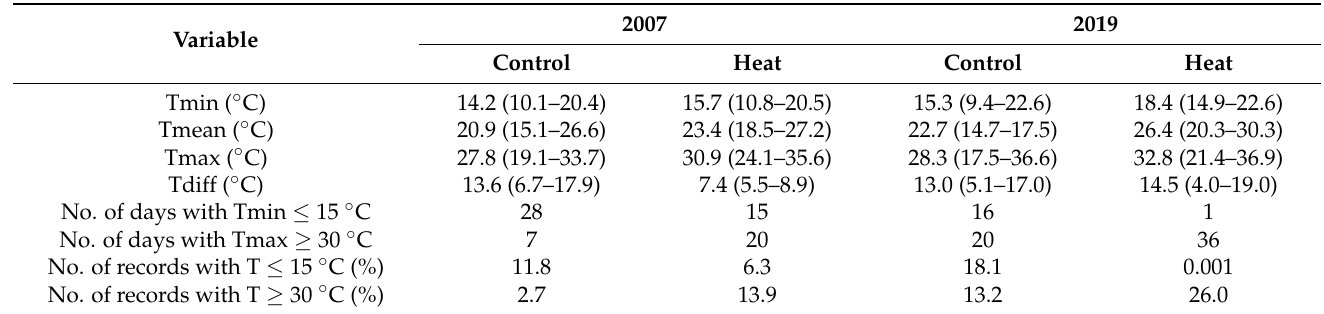
Table 2. Dynamics of minimum (Tmin), mean (Tmean), and maximum (Tmax) daily temperatures and daily variation (Tdiff) in the 40-d period from transplanting to flowering of the 2nd truss in the control and heat experimental fields and number of days (n = 40) and records (n = 960, reported in %) below 15 ◦ C and above 30 ◦ C in the same period in the two years. For Tmin, Tmean, Tmax, and Tdiff, the range is reported in brackets.